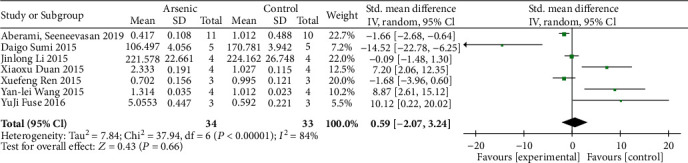
Meta-analysis of the effect of arsenic on the GCLC of r-GCS subunits in vivo. The forest plot shows the effect of arsenic treatment on GSH in the experiment and control group. SMD: standardized mean difference; IV: independent variable; 95% CI: 95% confidence interval; SD: standard deviation. The P value of the overall test effect is 0.66; when P < 0.05, the difference was considered statistically significant.